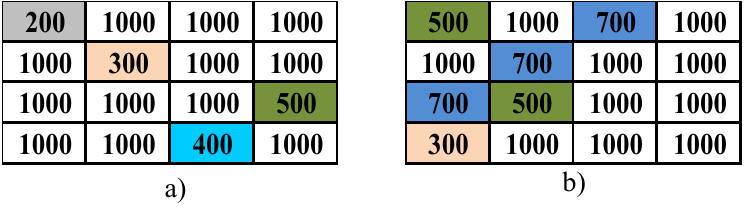
Figure 11. PSC after reconfiguration ( a ) case I, ( b ) case II.